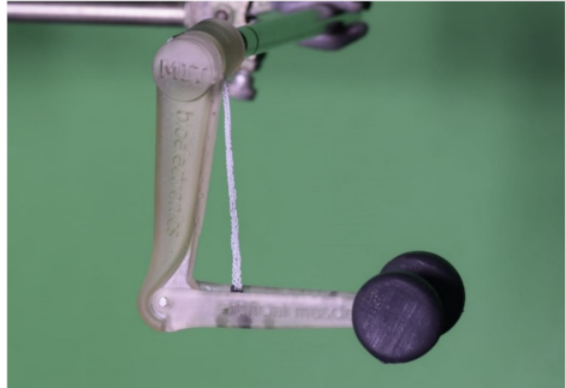
Figure 10. Miniature arm with bundled of fiber-based muscles formed by PE and COCe. (Photo courtesy from Mehmet Kanik and Sirma Orguc, Massachusetts Institute of Technology, Cambridge, MA,